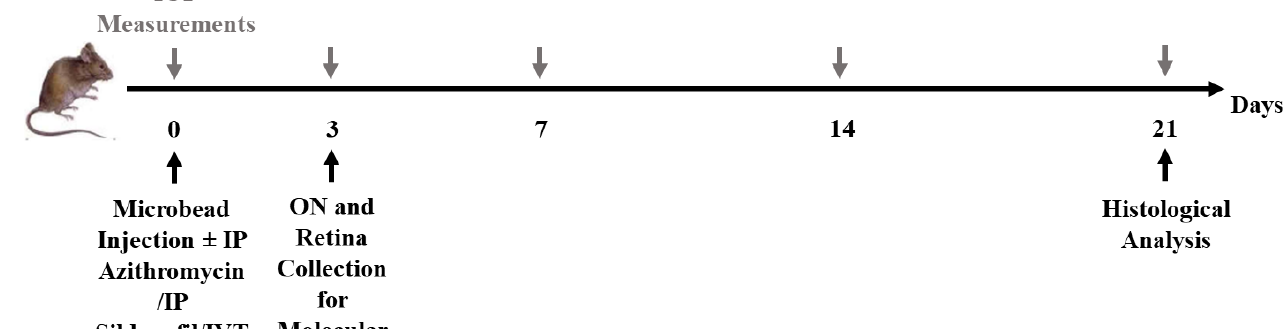
Figure 10. Research group allocation. The figure describes the different procedures and number of mice in each intervention group. Local interventions, including microbead injection, intravitreal azithromycin, or intravitreal sildenafil injections, were given to the right eye only. Both eyes under- went histological or molecular examination. IP, intraperitoneal; IVT, intravitreal; TLR4KO, toll-like receptor 4 knockout; WT, wild type.